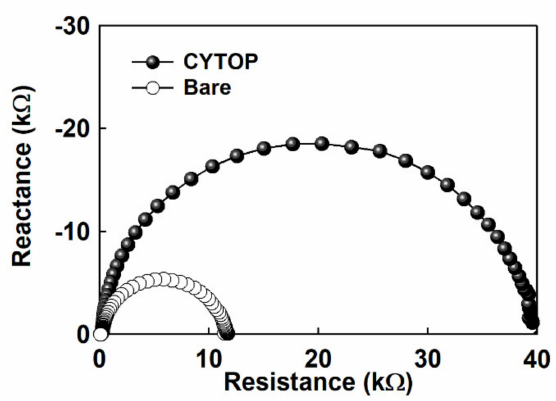
Figure 6. Cole–Cole plots of CYTOP-encapsulated and bare OSCs after 35-day shelf aging, measured by impedance spectroscopy in dark